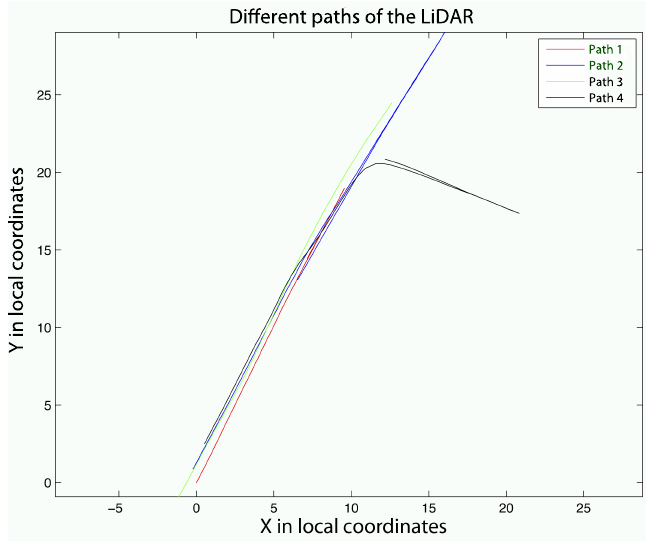
Figure 10. Comparison between the four